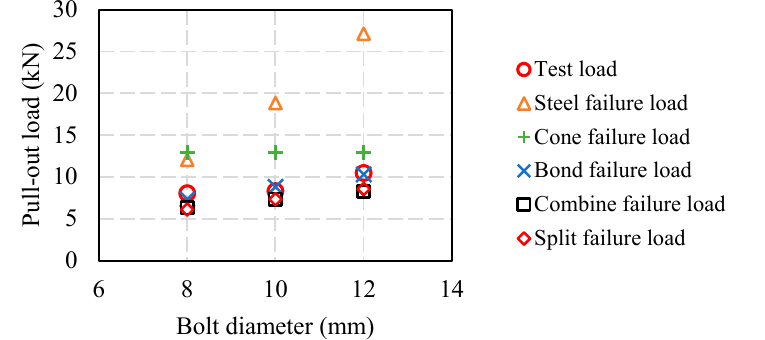
Figure 15. The comparison results of the pullout test and the prediction estimation.